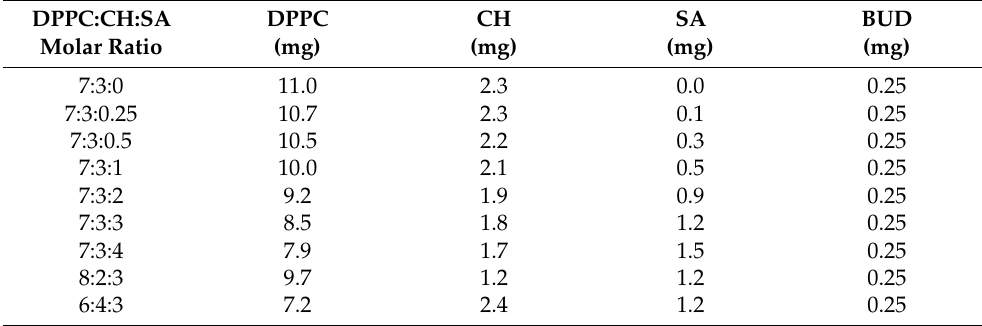
Table 1. Compositions of various liposomal formulations. The quantities mentioned below were used to prepare 1 mL of liposomal dispersions (20